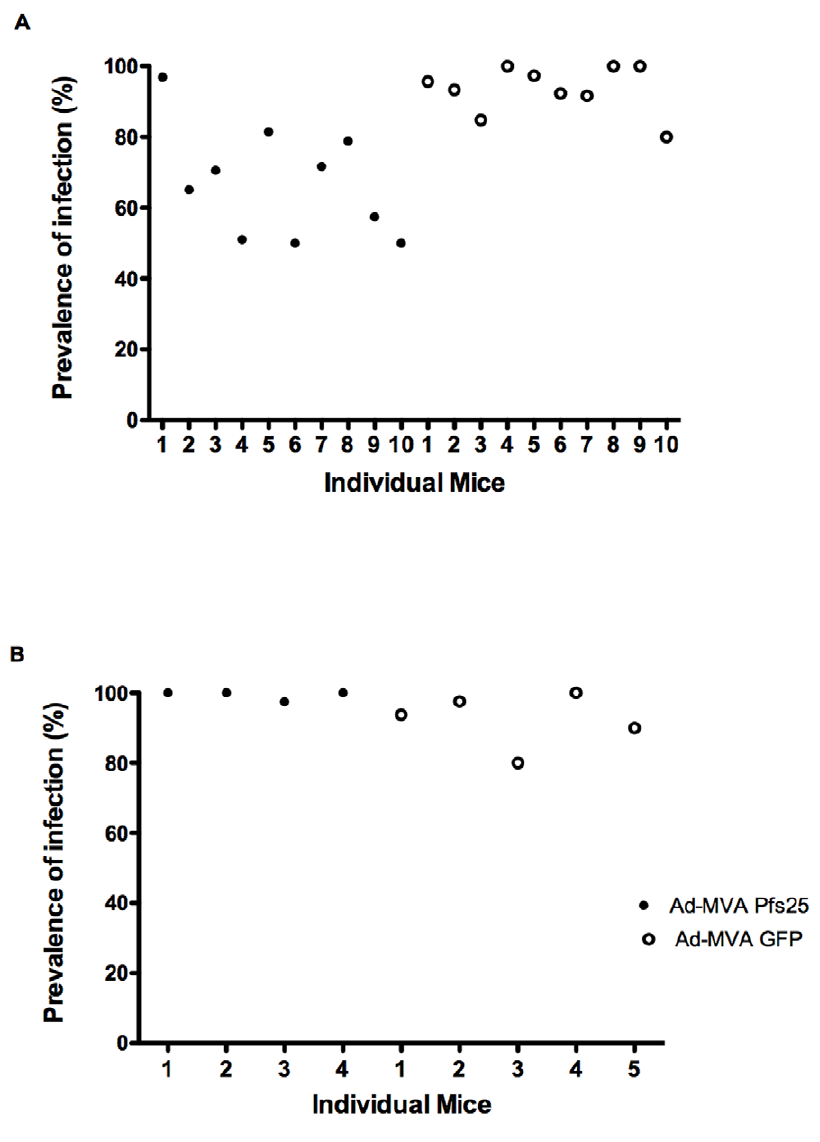
Figure 5. Parasite prevalence (per mouse) following Ad-MVA Pfs25 immunization. The same mosquitoes from figure 4 were analyzed for oocyst prevalence. Data points represent the prevalence of oocyst infection in mosquitoes that fed on individual mice, expressed as a percentage of total mosquitoes dissected.